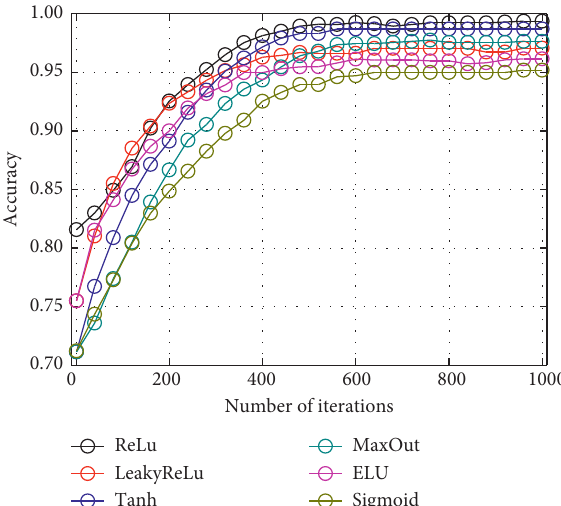
Figure 15: Comparison of accuracy of behavior recognition of six activation functions.